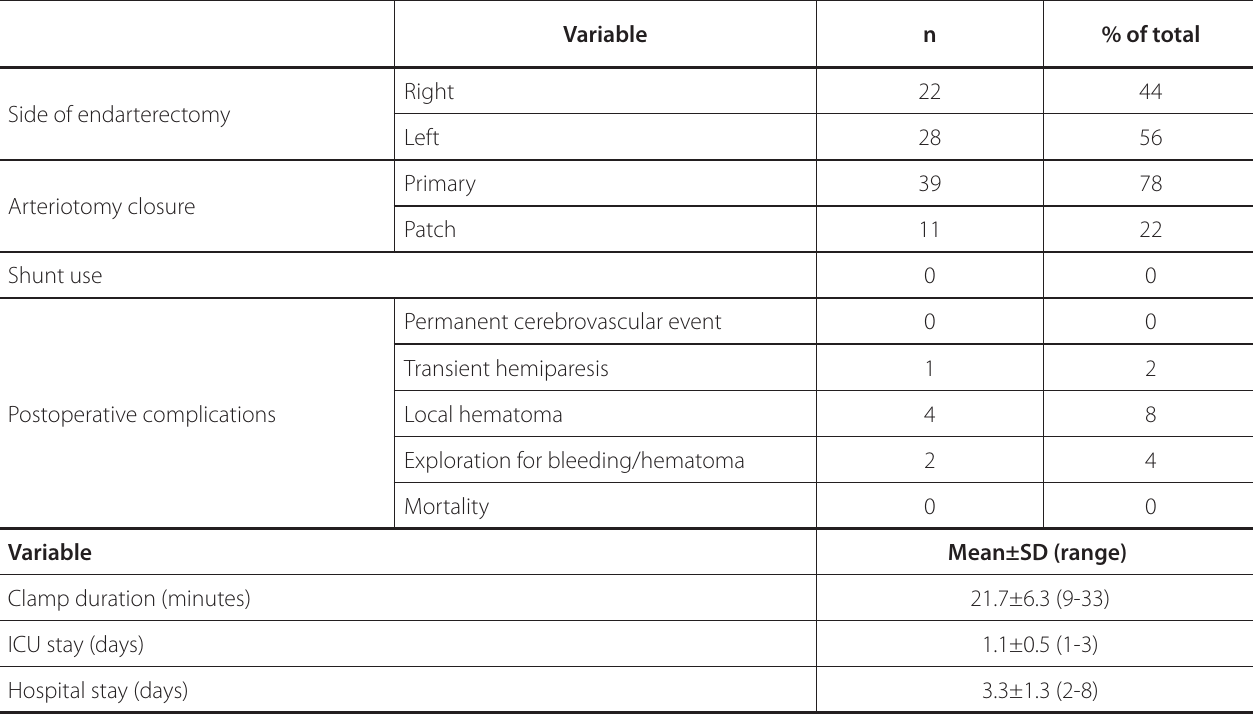
Table 2 . Operative and postoperative patient